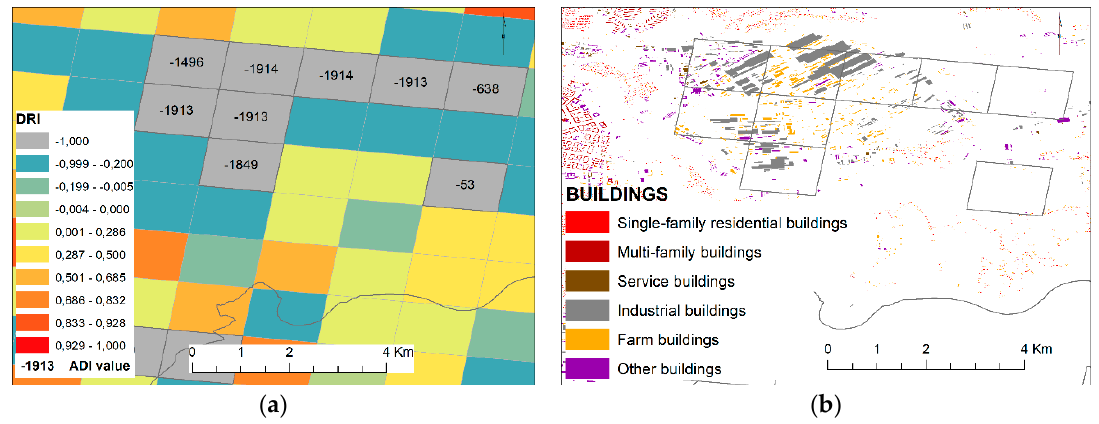
Figure 6. Krakow: ( a ) overestimation of LandScan data presented by DGI index and ADI values for the most overestimated cells; ( b ) Building types delivered from National Topographic database. Table 6. Overall global statistics of LS reliability classes shares in